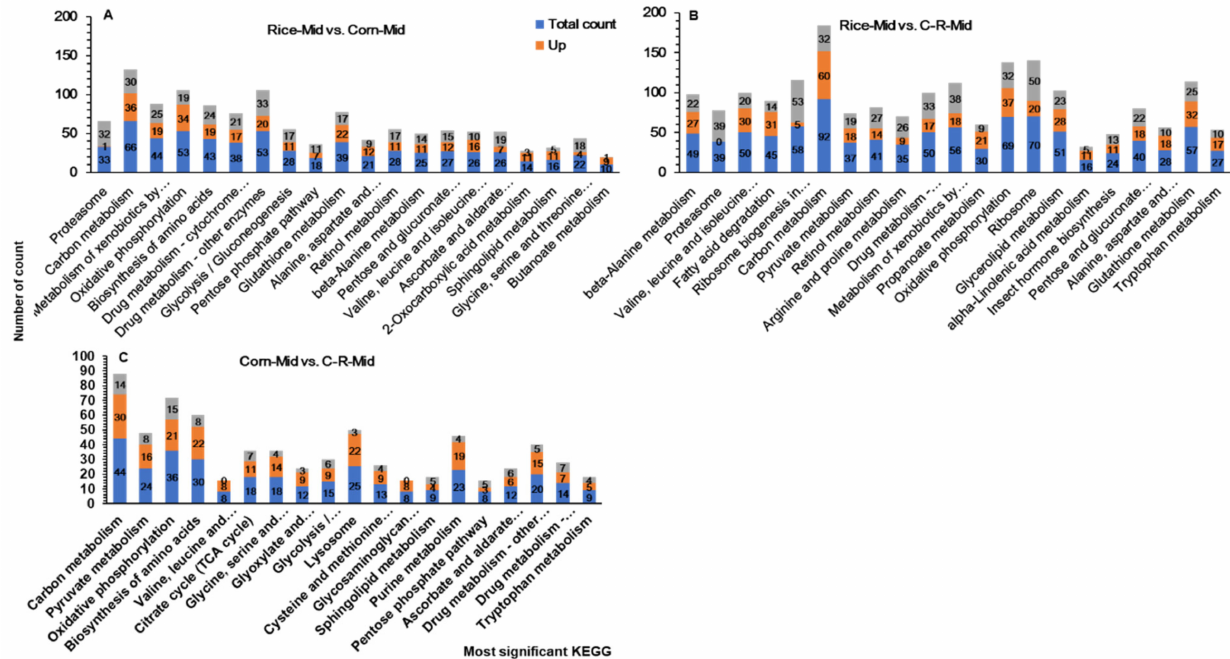
Figure 10. Enriched KEGG pathways for up and down regulated DEGs and the ratio of the DEG number to the total gene number in a certain pathway in the Rice-Mid vs. Corn-Mid ( A ), Rice-Mid vs. C-R-Mid ( B ), corn-Mid vs. C-R-Mid ( C ) (After 20 generation of selection the corn population was fed on rice for one generation (C-R-midgut) of Spodoptera frugiperda when reared on corn and rice plants for 20